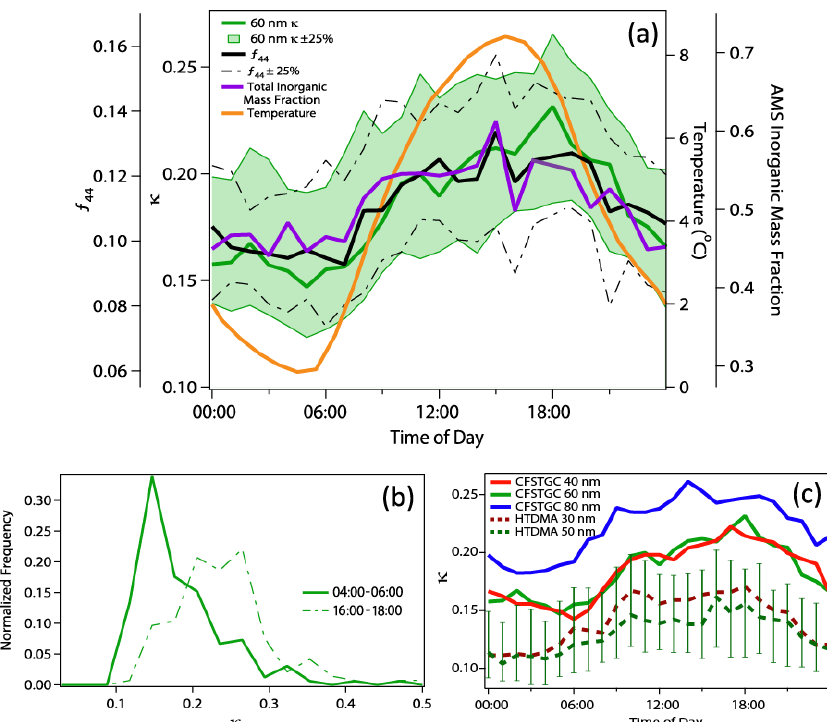
Fig. 7. (a) Diurnal trend of 60nm CFSTGC-derived median κ (green line) with 25th and 75th percentiles shaded in green. Also shown are average temperature (orange line), median f 44 , given by AMS (black line) with 25th and 75th percentiles shown by dotted black lines, and median inorganic mass fraction (purple line). (b) Frequency distributions of 60nm CFSTGC-derived κ values for times of minimum (solid line) and maximum (dotted line) κ values. (c) Diurnal CFSTGC-derived κ distributions for 40, 60, and 80nm particles and HTDMA-derived distributions for 30 and 50nm particles. Bars representing the 25th and 75th percentile values are shown for 60nm and 50nm data.